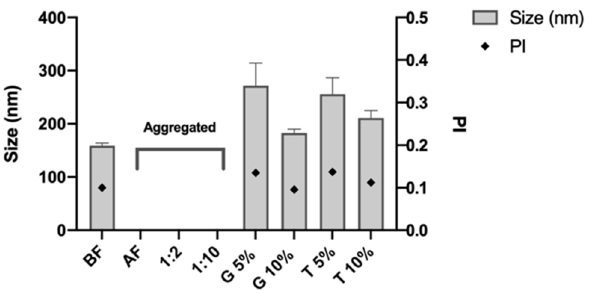
Figure 6. Physicochemical properties (size and polydispersity index) of dextran nanocapsules with imiquimod in their core (DX NC-imq*) once were subjected to freeze-dry process. BF: before freeze-drying. AF: after freeze-drying. 1:2 and 1:10: dilution in Milli-Q water. G: Glucose. T: Trehalose. PI: polydispersity index. * Formulation elaborated applying high manual pressure. (Mean ± SD, n = 3).